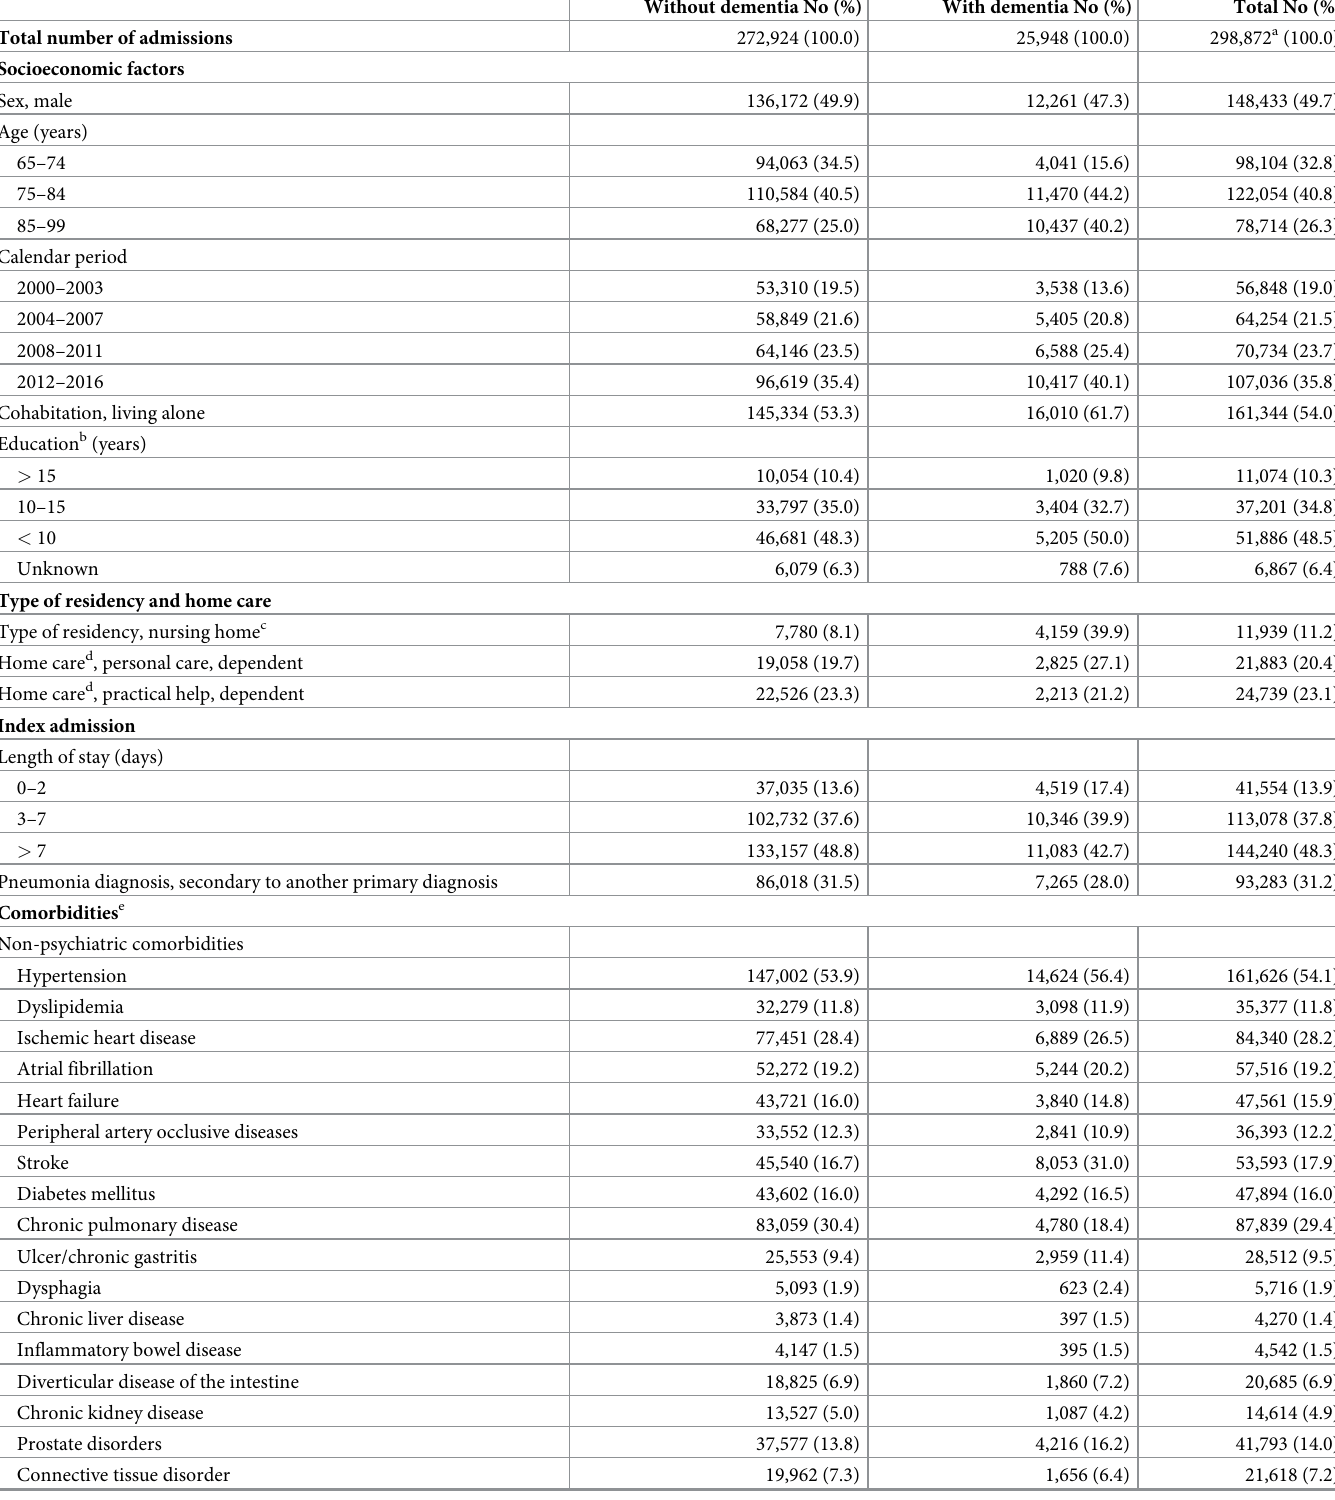
Table 1. Study cohort characteristics stratified on dementia status in 298,872